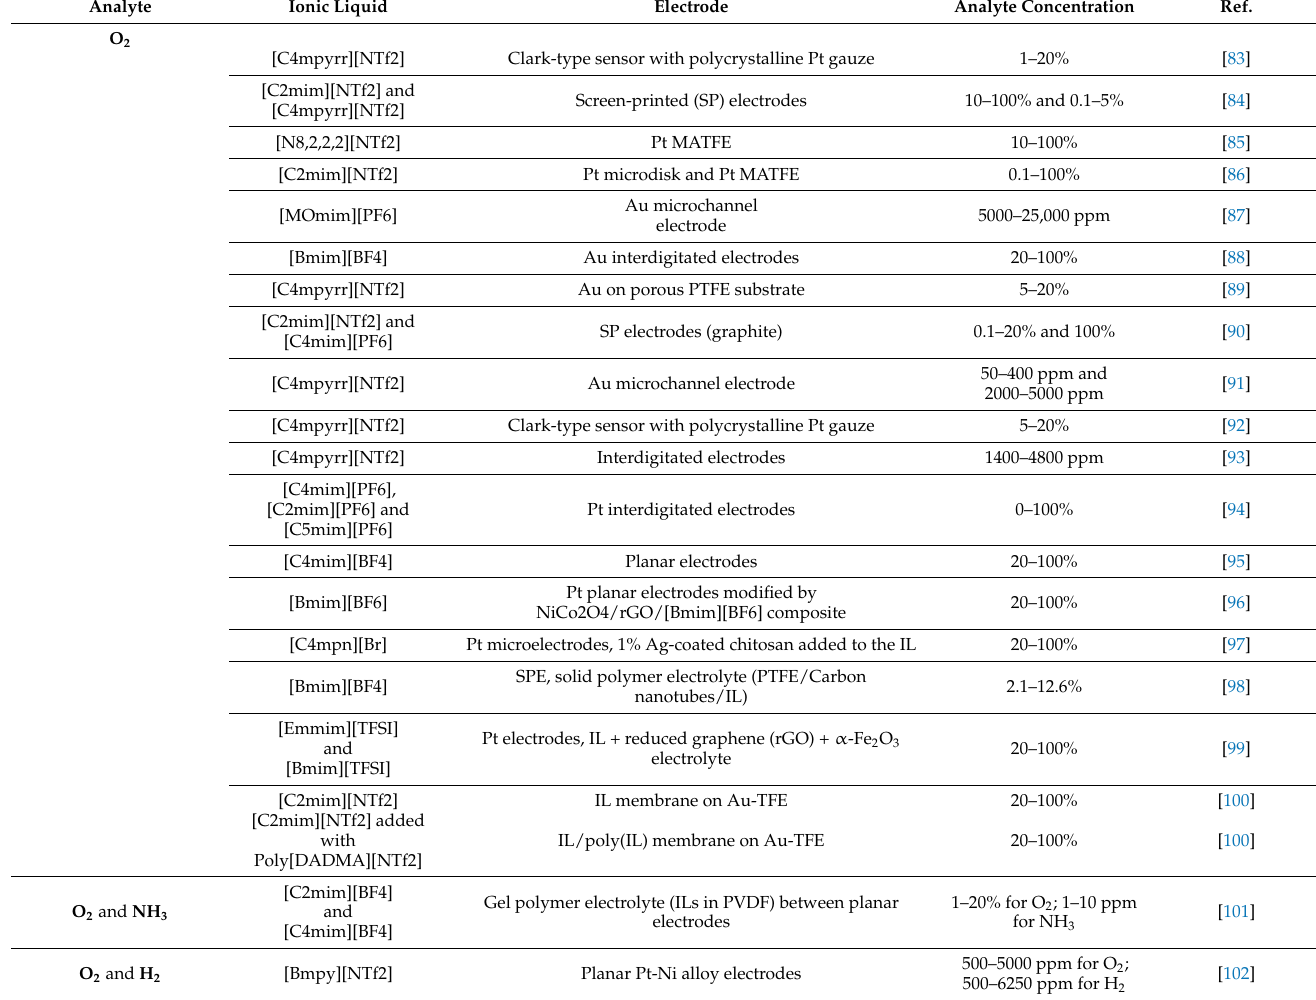
Table 2. References on AGS using ionic liquids (ILs) as solvents, ordered by